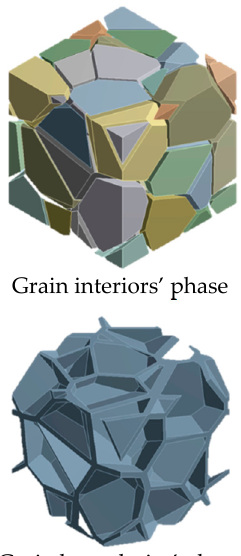
Figure 1. Representation of rule of mixtures (RoM) approach.